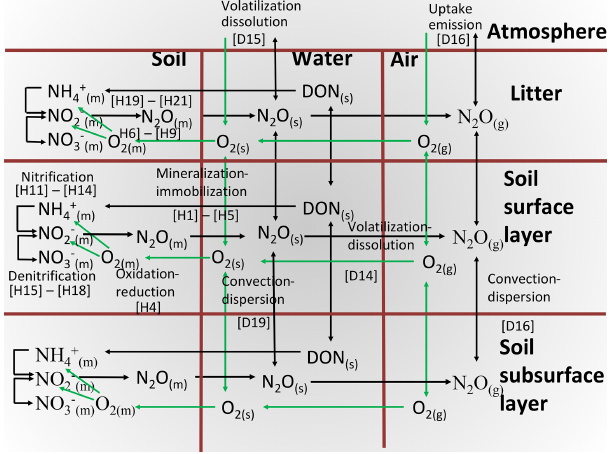
Figure 1. Key transformations governing N 2 O emissions as repre- sented in ecosys. Expressions in square brackets refer to equations in the Supplement, as described in Sect.